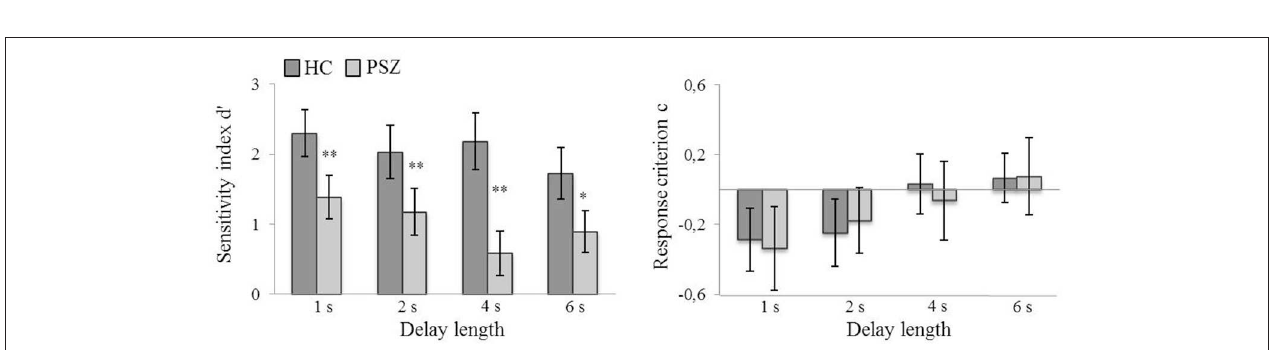
FIGURE 3 | Type of errors. Not-confident errors and confident errors at different delay lengths in patients with schizophrenia (PSZ) and healthy controls (HC). Error bars represent the standard error of the mean. Significant group differences at different delay lengths are marked. * indicates p < 0.05 and ** indicates p < 0.01, corrected for multiple comparisons. For confident errors, error variances were not equal across groups for delay lengths of 1s, 2s, and 4s (Levene’s test, p < 0.05). For not-confident errors, error variances were not equal across groups for delay lengths of 1s, 4s, and 6s (Levene’s test, p < 0.05).